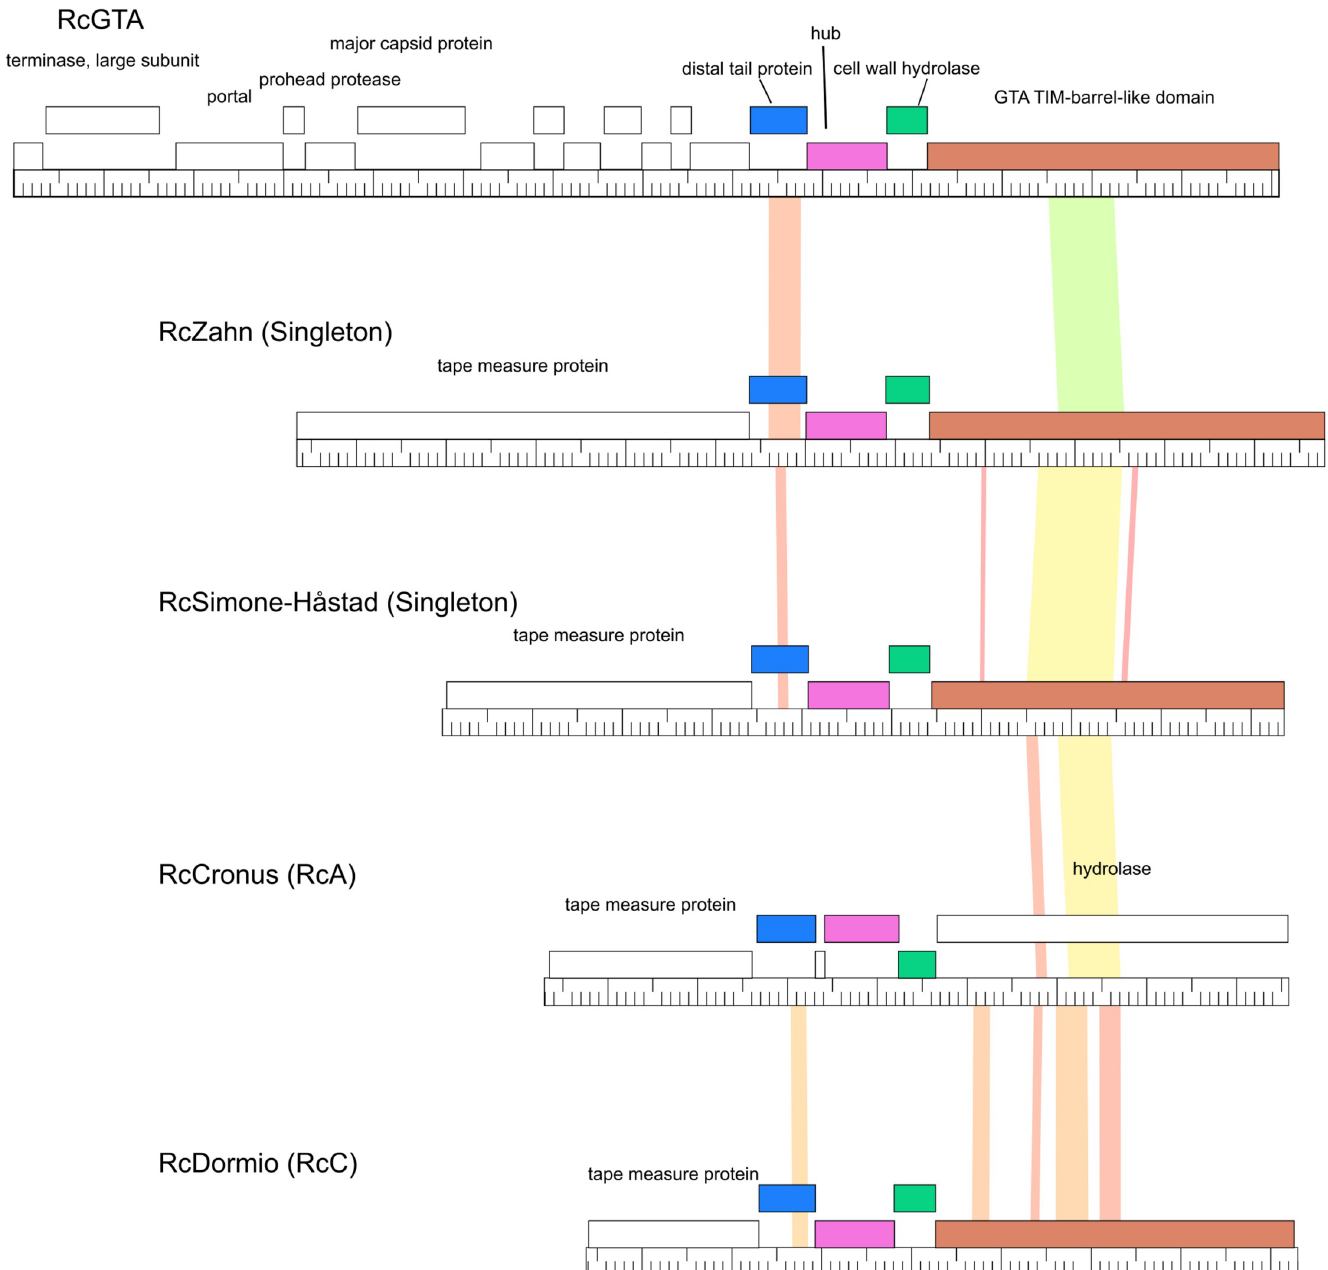
Fig 5. Genes shared with RcGTA. Genes shared between RcGTA, RcZahn, RcSimone-H å stad, and members of the RcA and RcC clusters are indicated by shared color. The locations of several of these proteins within the tail region of RcGTA particles have recently been identified [18]. Genes sharing the same coloration have been designated by Phamerator as being members of the same pham while those that are colorless are considered to be orphams as their amino acid sequence identity with any other predicted proteins in this database does not reach the 32.5% identity CLUSTALW threshold used by Phamerator. Regions of color between genomes highlight pairwise nucleotide sequence similarities. Colors towards the red end of the spectrum represent regions with reduced levels of similarity but still above the BLASTN cut off value of 10 − 4 that still warrants